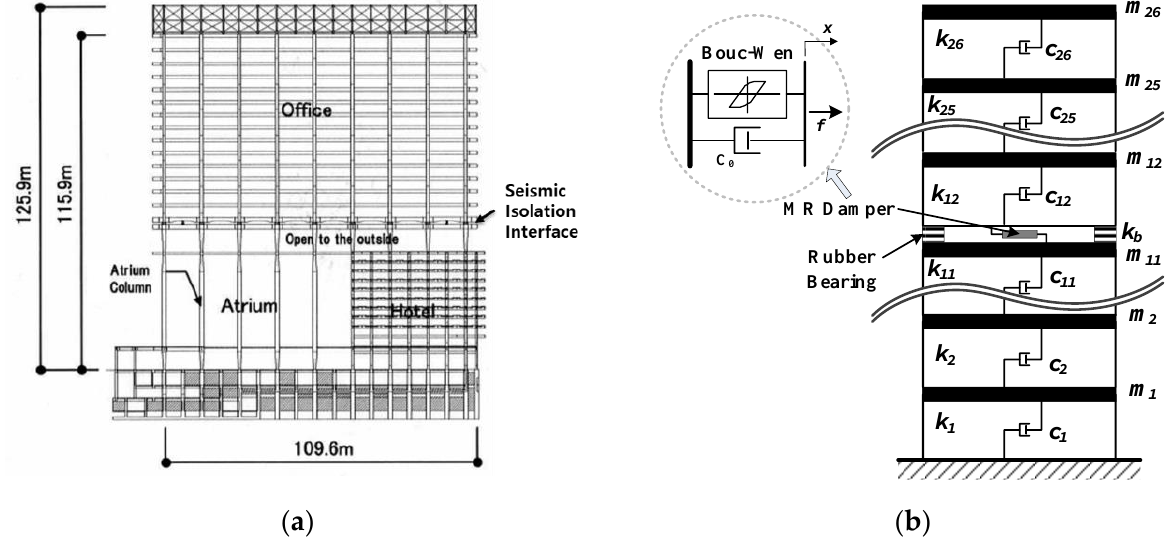
Figure 5. Sample building structure with a mid-story isolation system: ( a ) elevation of the Shiodome Sumitomo building [20], ( b ) analytical model with